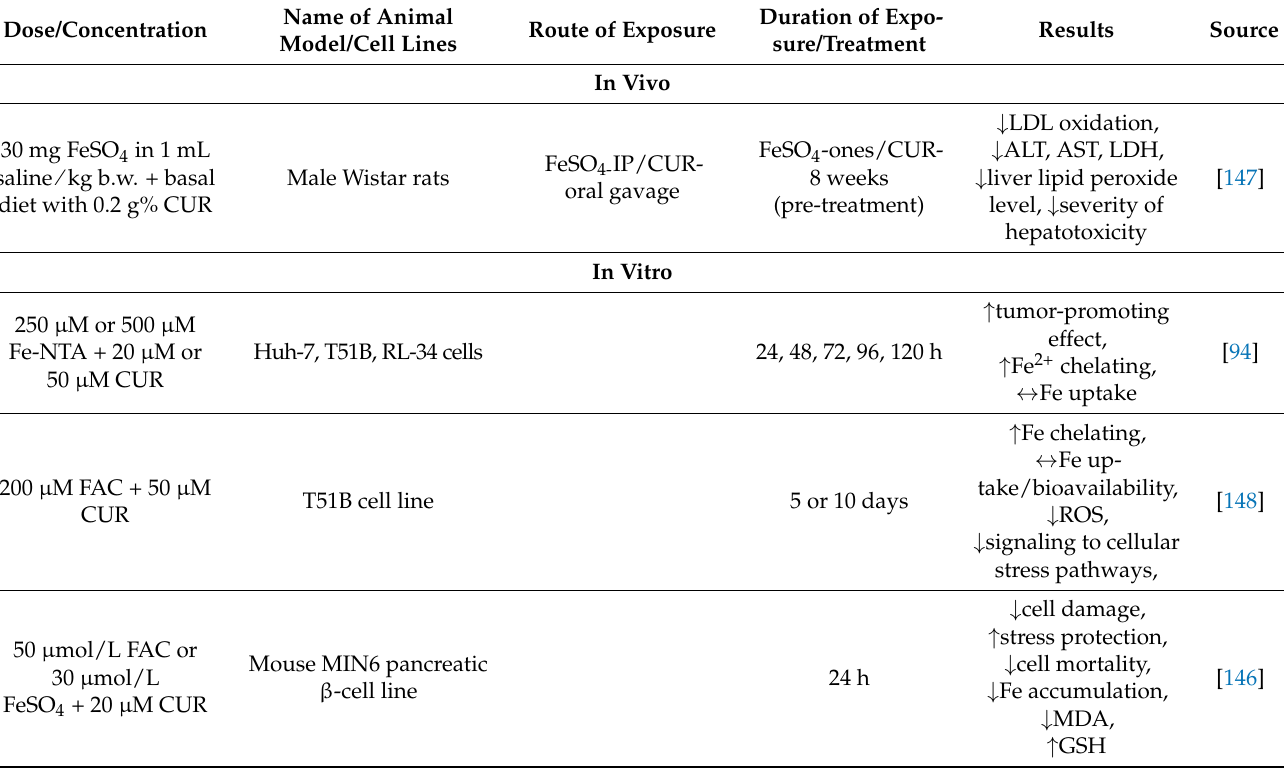
Table 6. Effects of curcumin on iron toxicity based on doses, experimental methods, and findings.